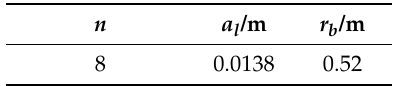
Table 1. Conductor parameters.